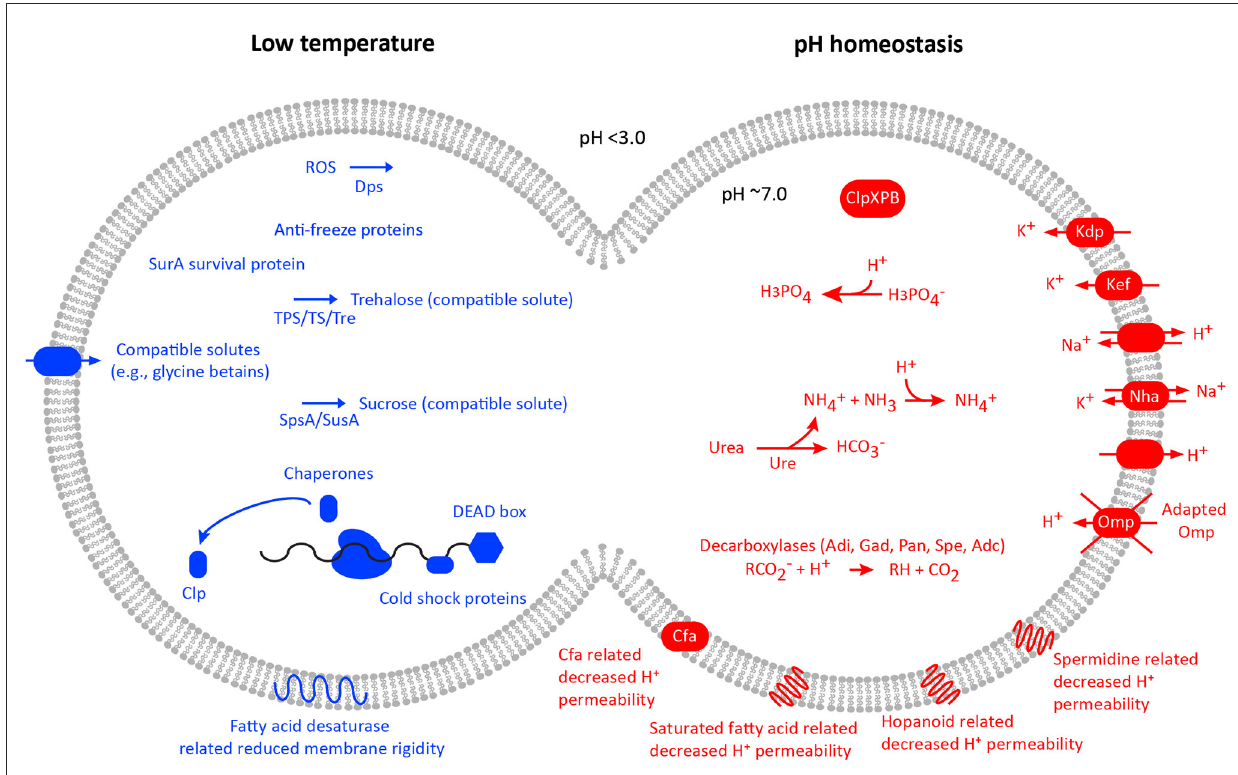
FIGURE4 Acidophile and low-temperature adaptations for selected genomes based upon complete genomes and type strains of the available species. Data used during the preparation of the figure were drawn from the AciDB database of acidophilic organisms (Neira et al., 2020).